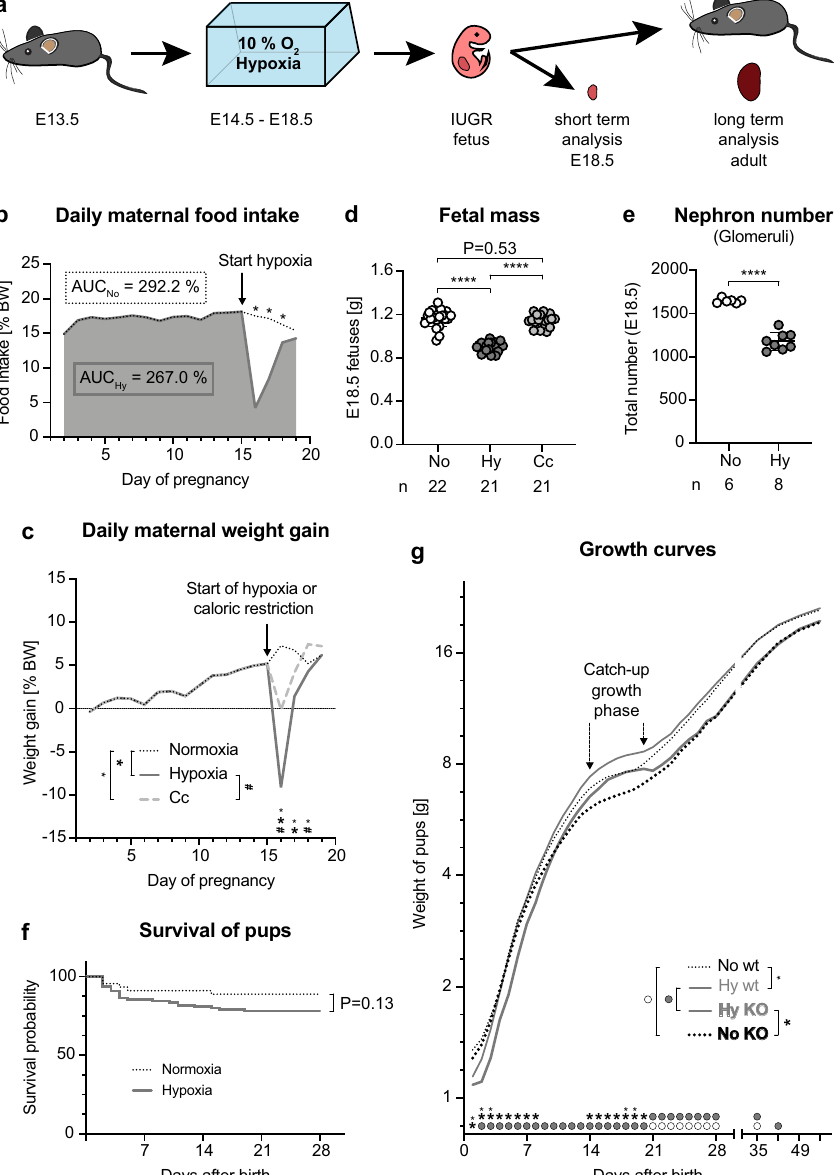
Fig. 1 Chronic fetal hypoxia induces intrauterine growth restriction in mice. a Experimental setup and time points of analysis. b Mean relative daily food intake shown for all dams until start of hypoxia (arrow), thereafter normoxic dams (black dotted line) or hypoxic dams (bold dark gray line) are separated. During whole gestation, normoxic dams consumed 292.2% of their body weight, while hypoxic mice ate 267%. This corresponds to 91.4% of the food consumed by normoxic mice. Asterisks denote signi fi cance (day 16 and 17 P < 0.0001, day 18 P = 0.0398). c Mean relative daily maternal weight gain shown for all dams until the start of intervention (arrow), thereafter normoxic dams (black dotted line), hypoxic dams (bold dark gray line), or Cc dams (dashed light gray line) are separated. Signi fi cance is denoted by large asterisks (normoxia vs. hypoxia: day 16 and 17 P < 0.0001), small asterisks (normoxia vs. Cc: day 16 P = 0.0002, day 17 P = 0.0012, day 18 P = 0.0082) or # (hypoxia vs. Cc: day 16 P < 0.0001, day 18 P = 0.0007). d Fetal mass shown as mean ± SEM. N = fetuses. Ordinary one-way ANOVA with Tukey ’ s multiple comparison test. e Number of nephrons per E18.5 kidney determined by staining for the glomerular marker nephrin shown as mean ± SEM. N = fetal kidneys. Unpaired 2-sided t -test with Welch ’ s correction. f Survival of normoxic and hypoxic pups. Mantel-Cox log-rank test. g Mean postnatal weight of hypoxic offspring ( Ahsg KO — bold gray line, wild-type-thin gray line) and normoxic offspring ( Ahsg KO — bold black dotted line, wild-type — thin black dotted line). KOs weighed less than wild-types, catch-up growth was observed for hypoxic offspring during the third week after birth. Gray circles denote signi fi cance between hypoxic offspring, white circles between normoxic offspring, large asterisks between KOs, and small asterisks between wild-types. P -values are listed in Supplementary Table 8. Individual P -values are denoted above the comparison lines ( d , e ). N = dams ( b , c ) or pups ( f , g ) can be derived from Source Data. Multiple 2-sided t -tests ( b , c , g ). (**** P < 0.0001). Source data are provided as a Source Data fi